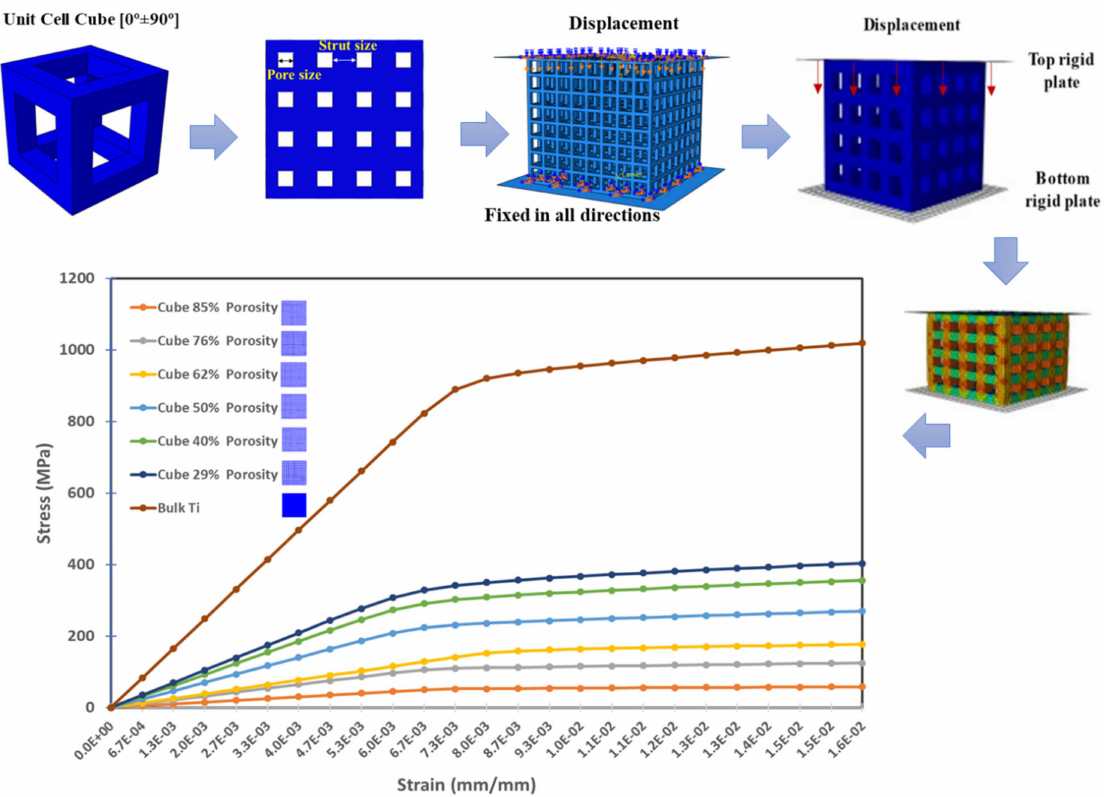
Figure 1. Porous structure designs sample for finite element model to study the mechanical properties of different volumetric